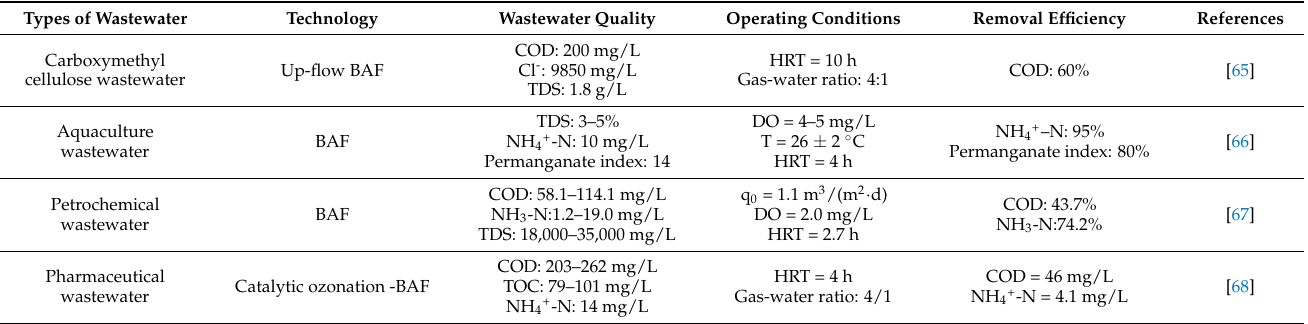
Table 7. Performance and experimental conditions of BAF for the treatment of saline